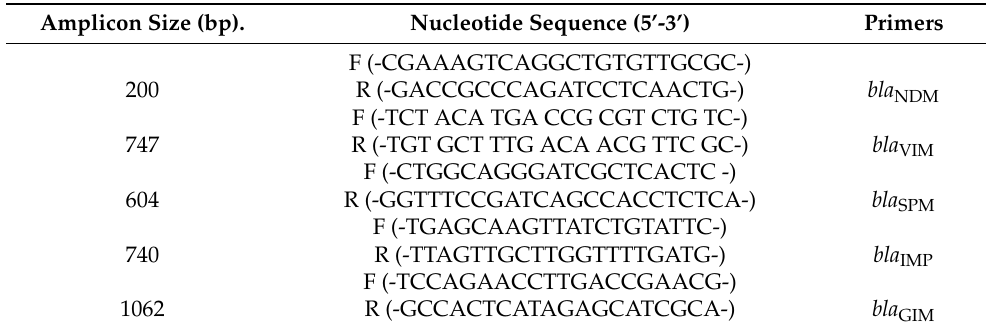
Table 8. Sequence and expected product sizes of primers used for amplification of bla NDM,VIM,SPM,IMP,GIM genes. Amplicon Size